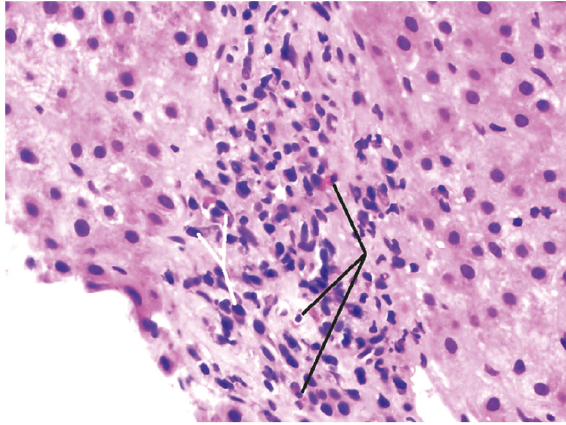
Figure 1: Liver biopsy. The portal triad demonstrates plasma cells (white arrows) and eosinophils (black arrows) consistent with autoimmune hepatitis. H&E stain, high power